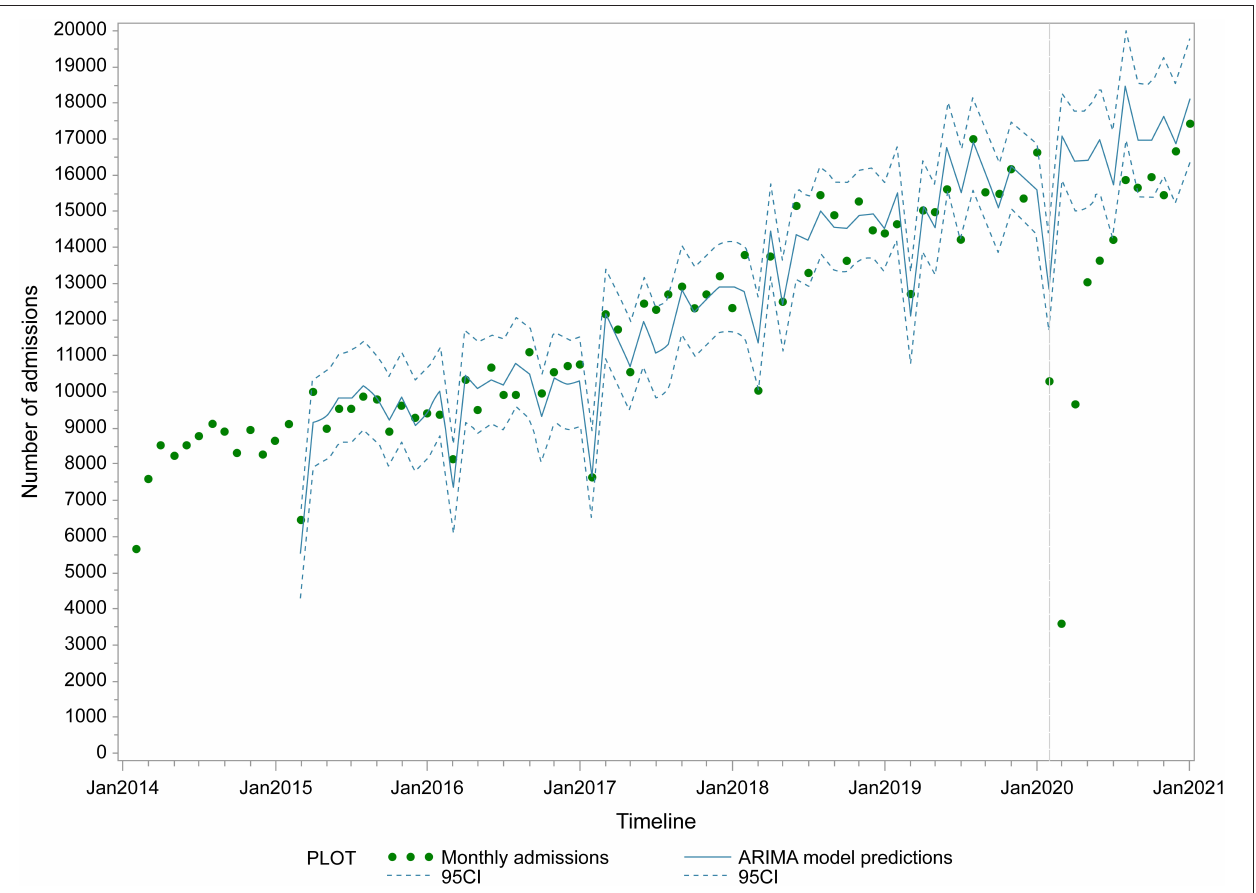
FIGURE 1 | Overall monthly admissions before and after the COVID-19 lockdown in Henan Cancer Hospital. Points represent monthly number of hospital admissions. Vertical lines represent change-point (lockdown). Fitted line represents ARIMA regression model of the admissions. Surrounding dashed lines represent 95% confidence